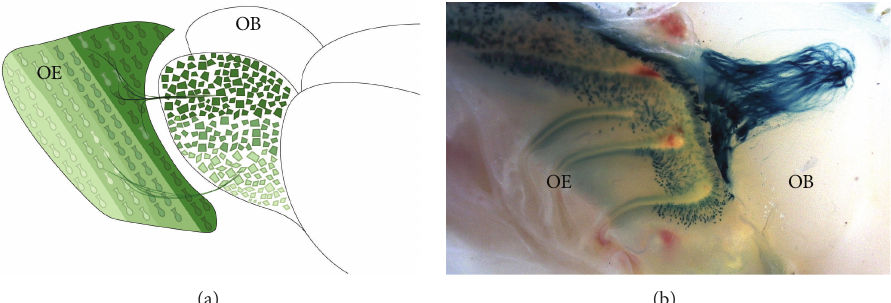
Figure 2: Regionalization of OSN populations in the OE and the corresponding position of glomeruli in the OB. (a) There is a gradational regionalization of the different OSN populations across the dorsoposterior-ventroanterior axis. A dorsoventral correspondence of glomerular position holds up in the OB. (b) The lateral view of the OB of a M72-tau-LacZ mouse is shown. M72 neurons are located in the dorsoposterior OE and the M72 glomerulus in the dorsal part of the OB. Beta-galactosidase (blue) activity was revealed by X-gal.